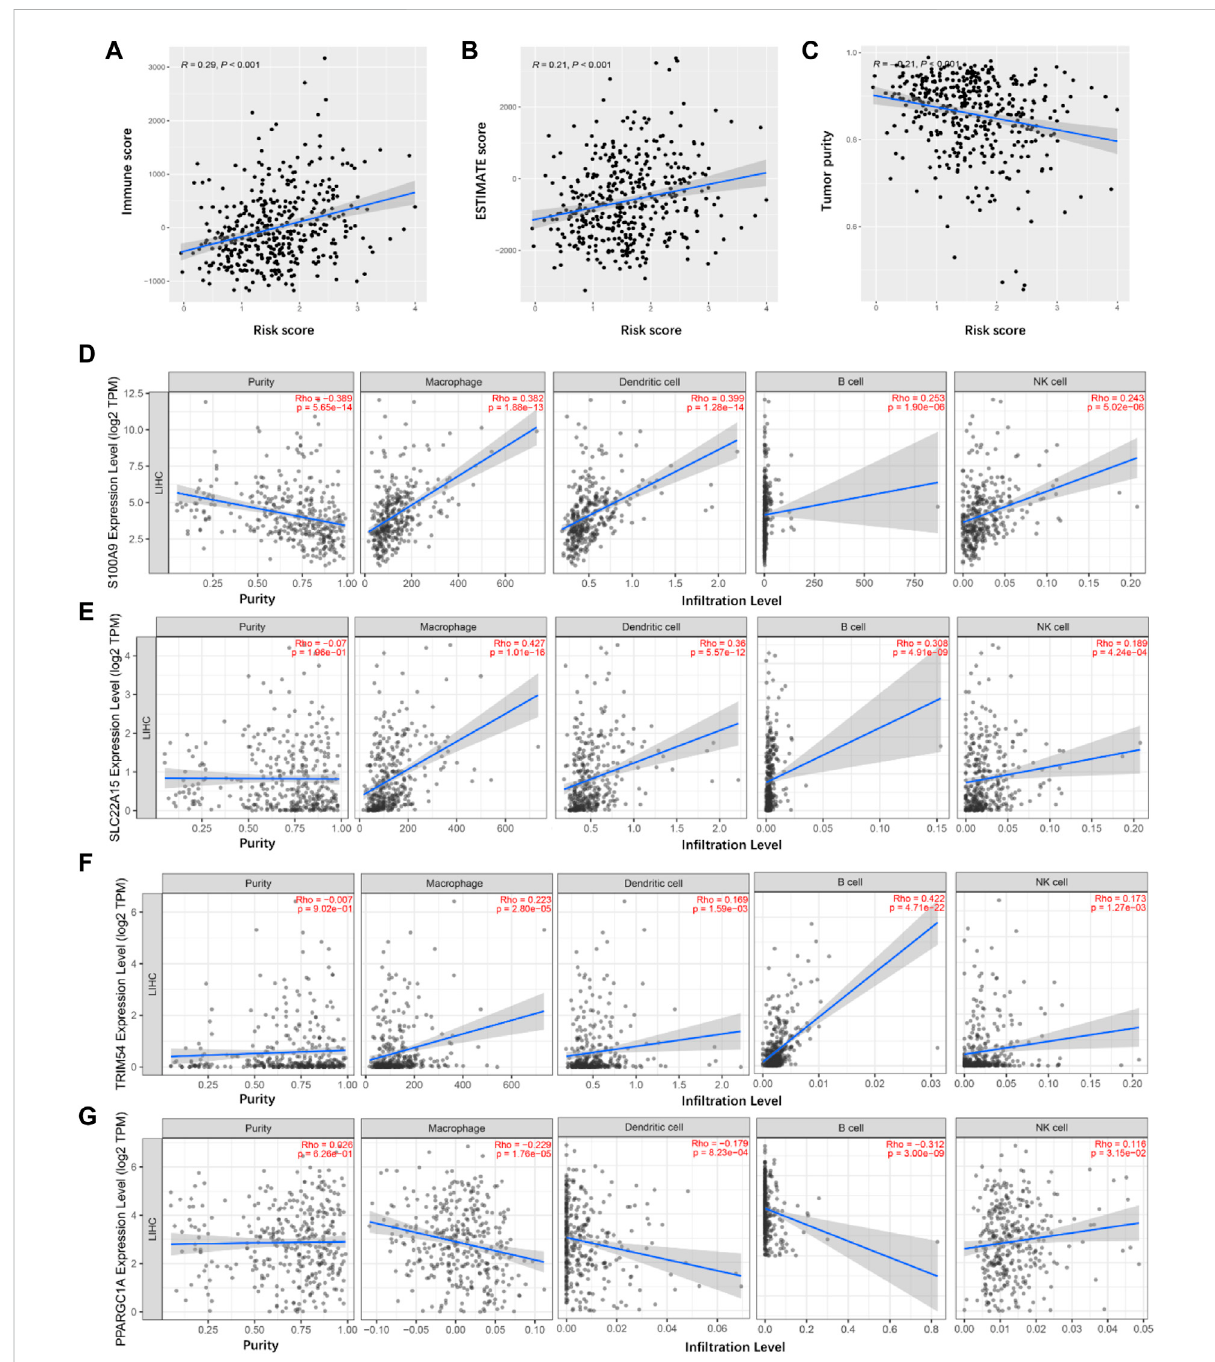
FIGURE 8 Tumorimmunemicroenvironmentanalyses. (A) CorrelationbetweentheimmunescoreandriskscoreinTCGAcancersamples. (B) Correlation between the ESTIMATE score and risk score in TCGA cancer samples. (C) Correlation between the tumor purity and risk score in TCGA cancer samples. (D – G) Identi fi cation of TIMGs associated with